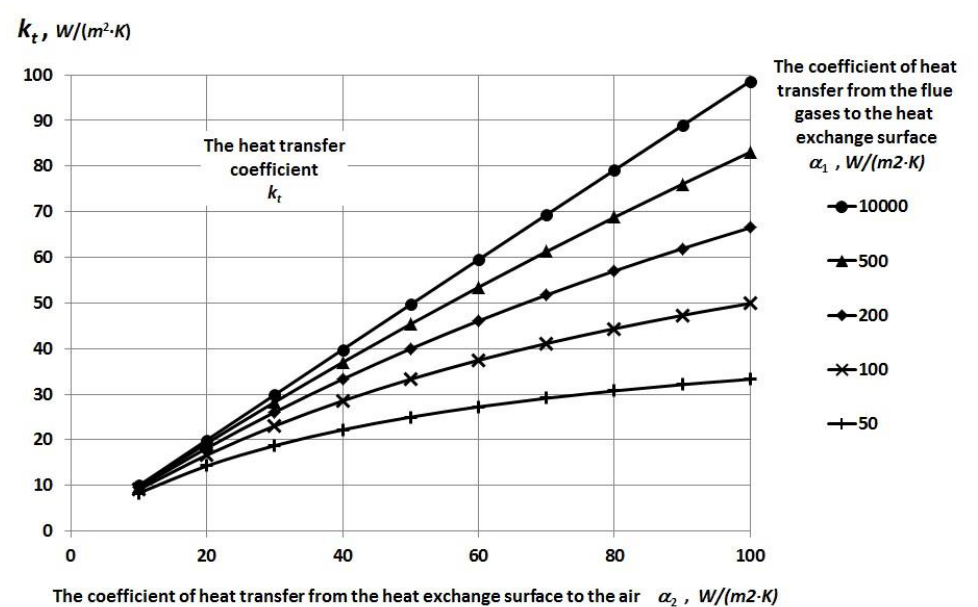
Figure 2. The (cid:3) 1 influence on the heat transfer coefficient. For small values (cid:3) ( (cid:3) << (cid:3) ) the heat transfer coefficient depends mainly on the heat transfer 1 1 2 from the condensable vapor in the flue gas stream (cid:3) . For large values (cid:3) ( (cid:3) >> (cid:3) , (cid:3) > 500), the 1 1 1 2 1 heat transfer coefficient to a greater extent depends on the heat transfer from the air (cid:3) . In the 2 considered heat recovery condenser (cid:3) less than 100 W/ ( m 2 ∙ K ). Due to condensation, the heat transfer 2 from the wet flue gas is much higher if turbulent regime is